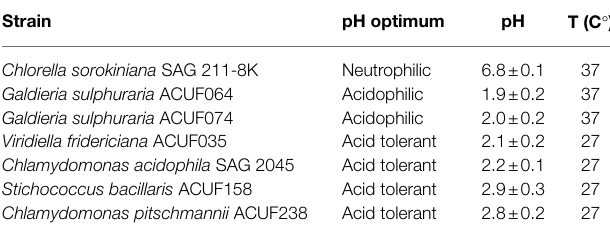
TABLE 1 | Temperature and pH used during the autotrophic